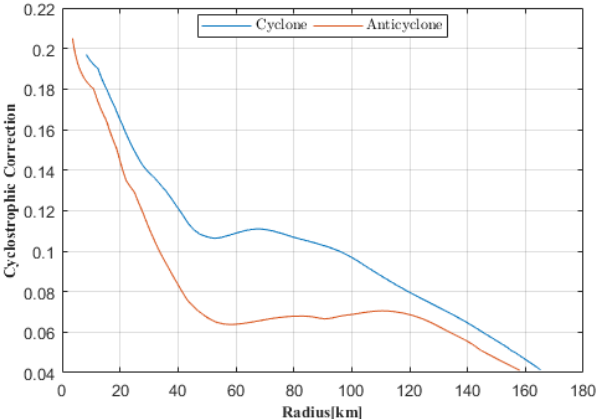
Figure 6. Ratio of the centrifugal to the Coriolis accelerations V θ / f 0 R for the cyclone and the anticyclone of the Ras al Hadd